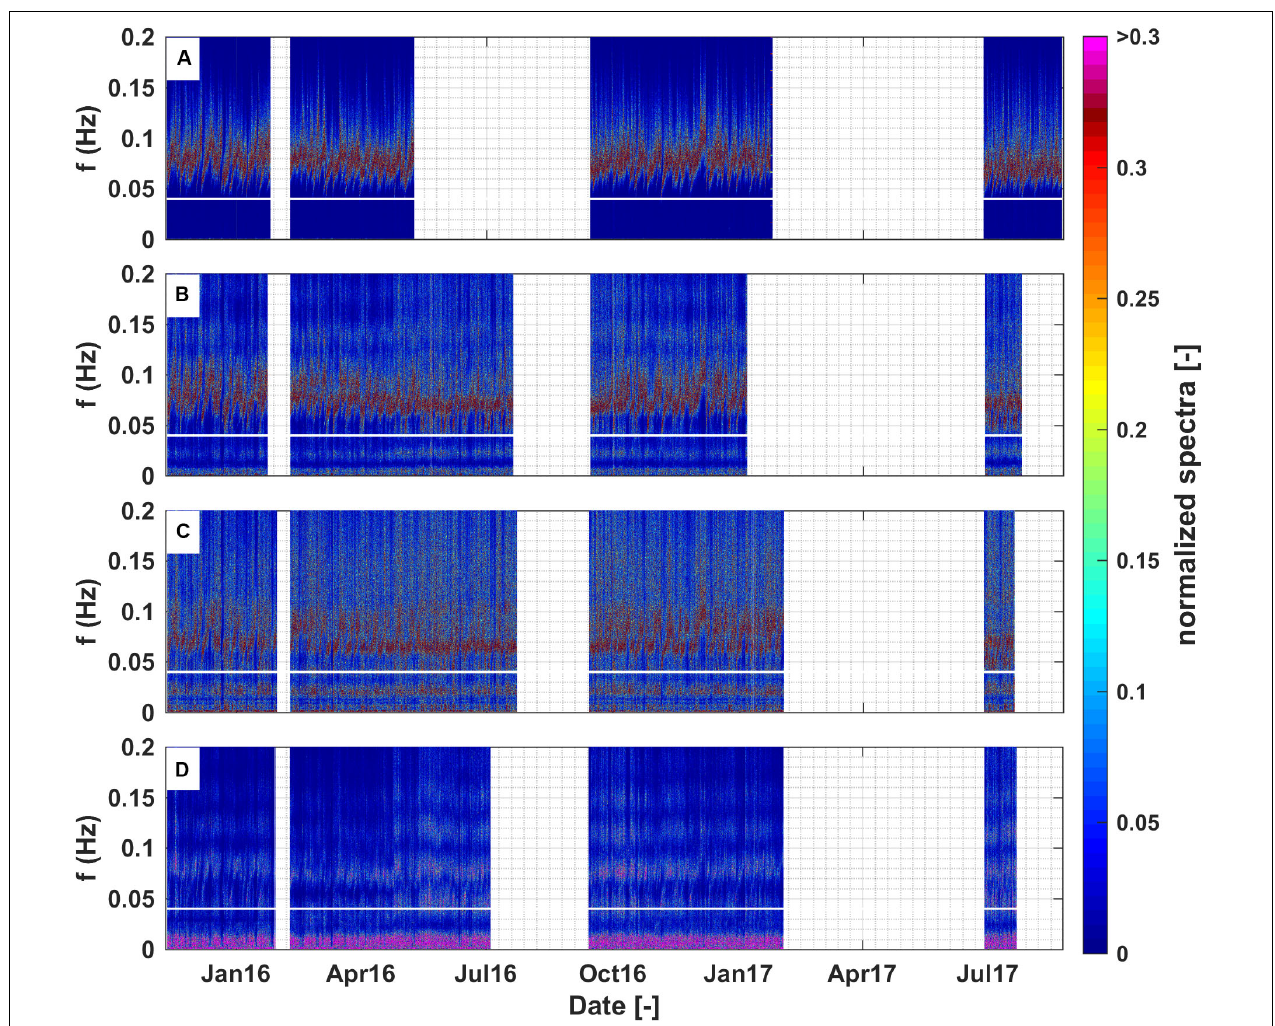
FIGURE 5 | Time series of normalized energy density spectra (against the maximum value of each hourly spectra) at (A) offshore, (B) A1, (C) A3, and (D) A6 (see Figure 1A for site descriptions) with spectra resolution of 0.0005 Hz. The horizontal white line on the figures represents the separation frequency (fsplit of 0.04 Hz) for the short-wave and infragravity bands. Blank parts on the figures denote the periods without